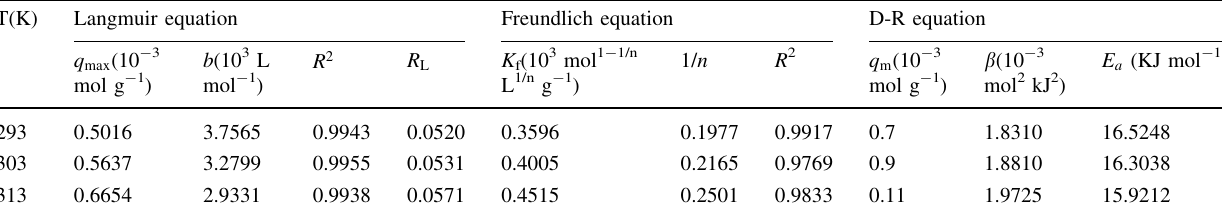
Table 2 Isotherm constants for the adsorption of Co (II) onto the resin at different temperatures T(K) Langmuir equation Freundlich equation